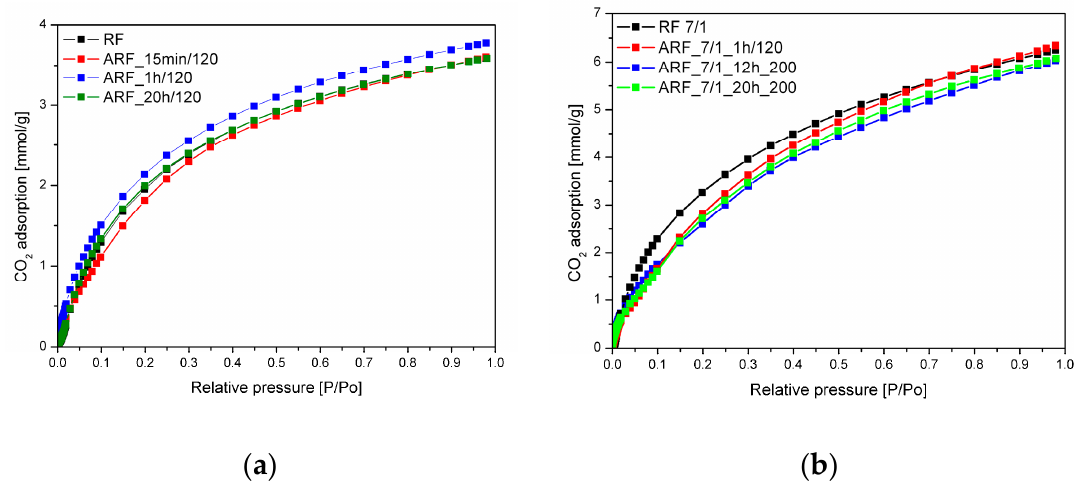
Figure 5. Exemplary CO 2 adsorption isotherms at 0 °C for the unmodified samples ( a ) and samples modified with potassium oxalate ( b ).